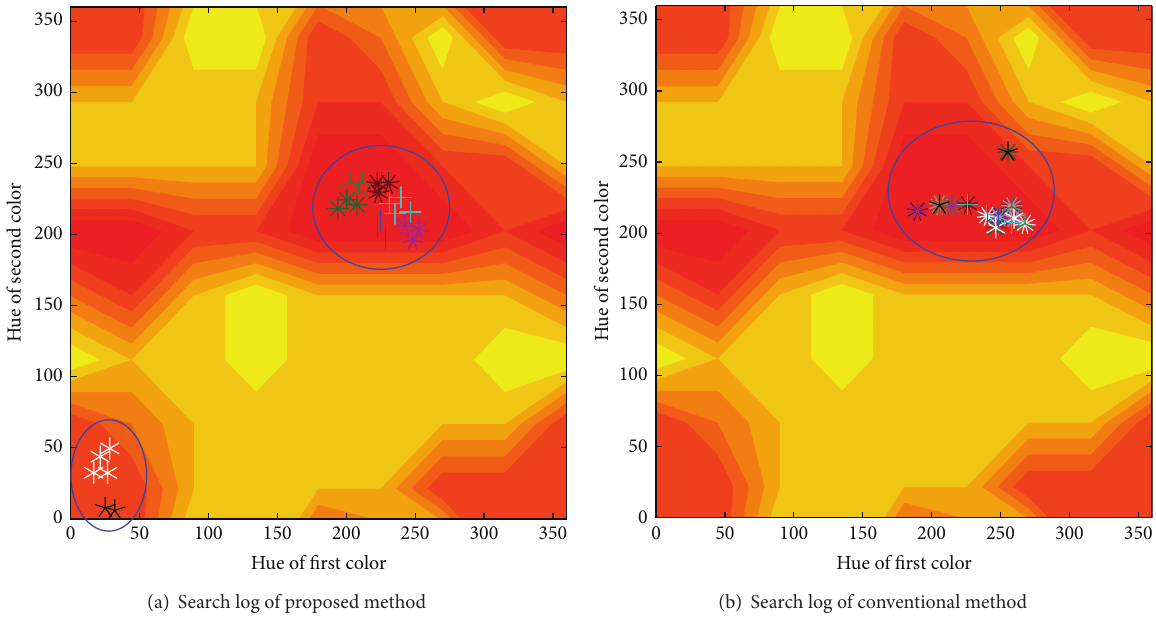
Figure 21: Search logs of the last generation for the multimodal landscape (for the plaid pattern).